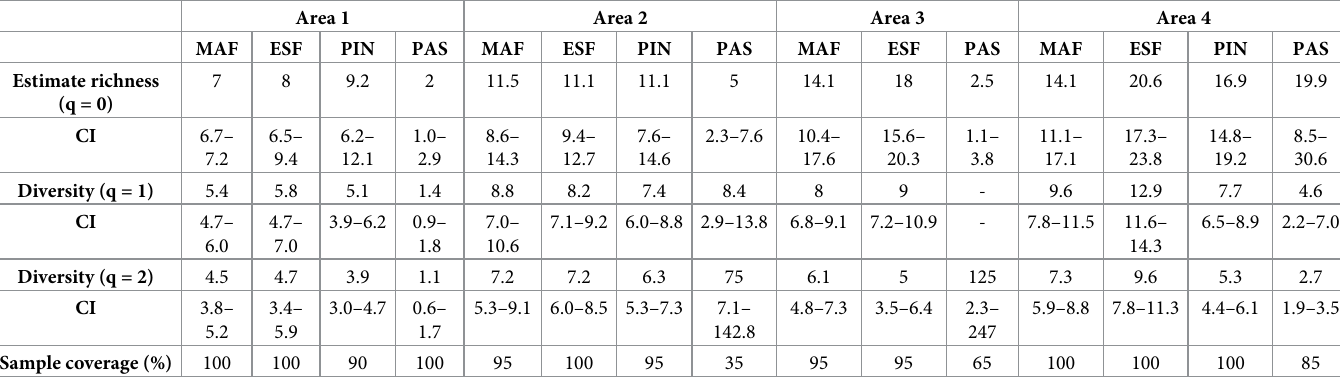
Table 2. Taxonomic diversity based on Hill